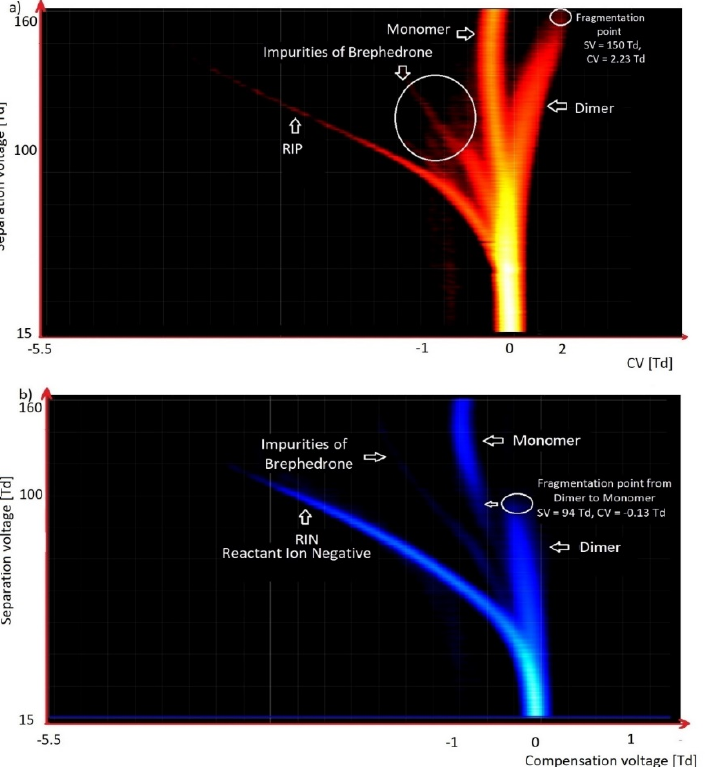
Figure 16. DMS spectrograms of brephedrone ( 1-(4-bromofenylo)-2-(metyloamino)-propan-1-on): ( a ) positive mode; ( b ) negative mode.